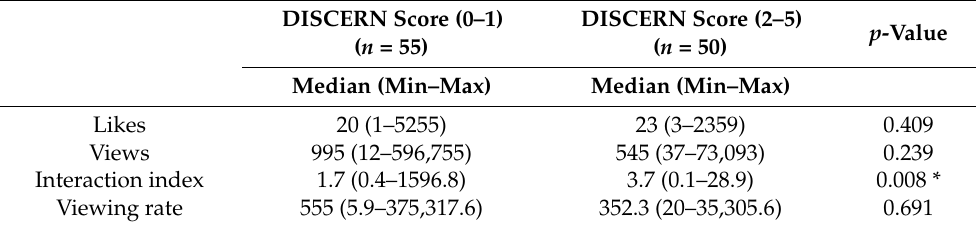
Table 5. Comparison of popularity and visibility based on reliability.